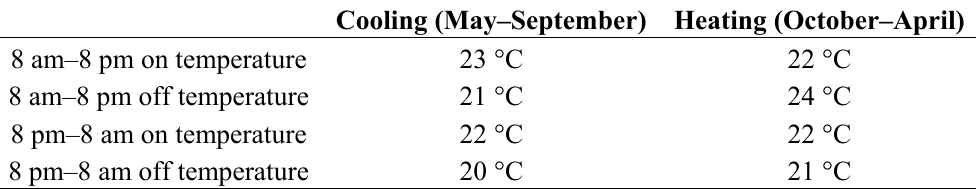
(cid:3003)(cid:3048)(cid:3036)(cid:3039)(cid:3031)(cid:3036)(cid:3041)(cid:3034)